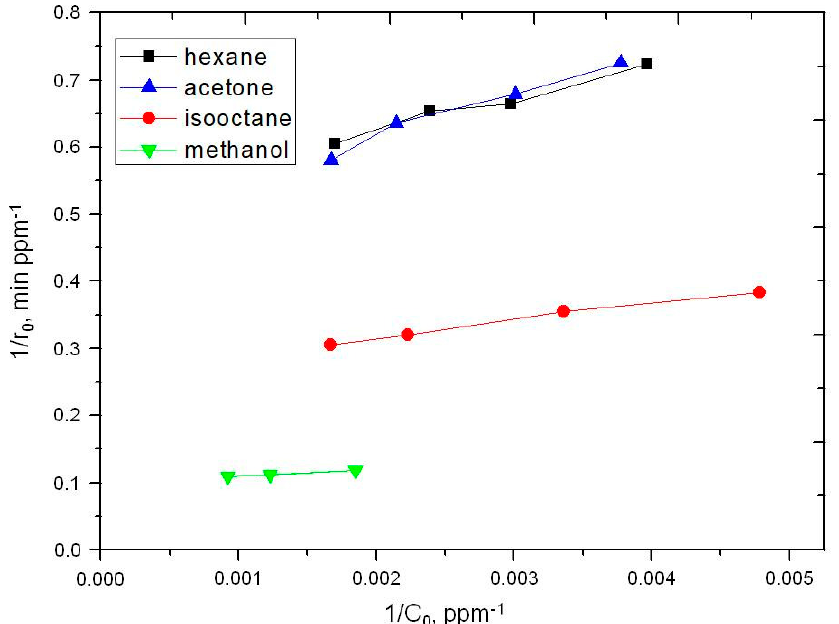
Figure 7. Langmuir–Hinshelwood plots (eq. 4) relative to hexane (square), isooctane (triangle up), acetone (circle) and methanol (triangle down). The experimental error is ≤ 10%. Table 2. Langmuir–Hinshelwood parameters (k and K) relative to the photosensitized oxidation of hexane, acetone, isooctane and methanol.